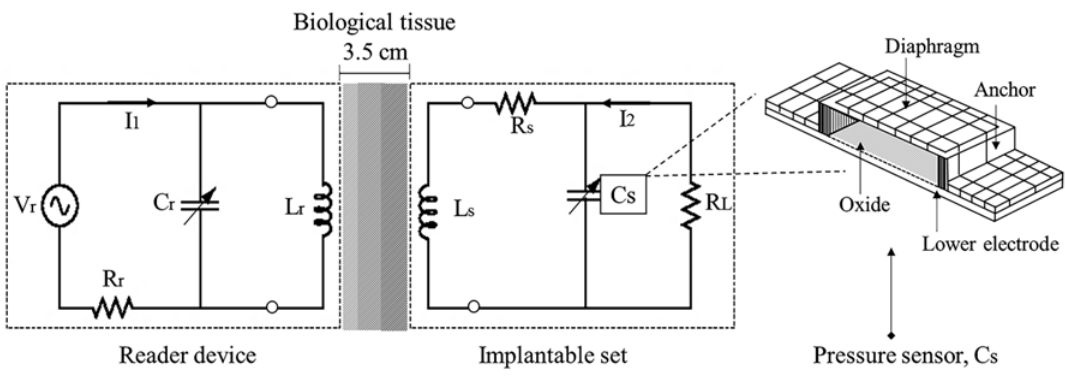
Figure 1. Electrical model for the inductive power transfer system.